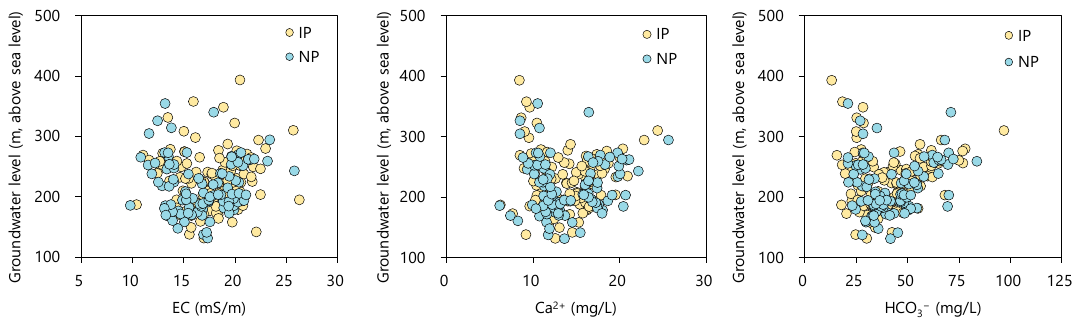
Figure 6. Relationships between EC, Ca 2 + , and HCO 3 − with groundwater level.